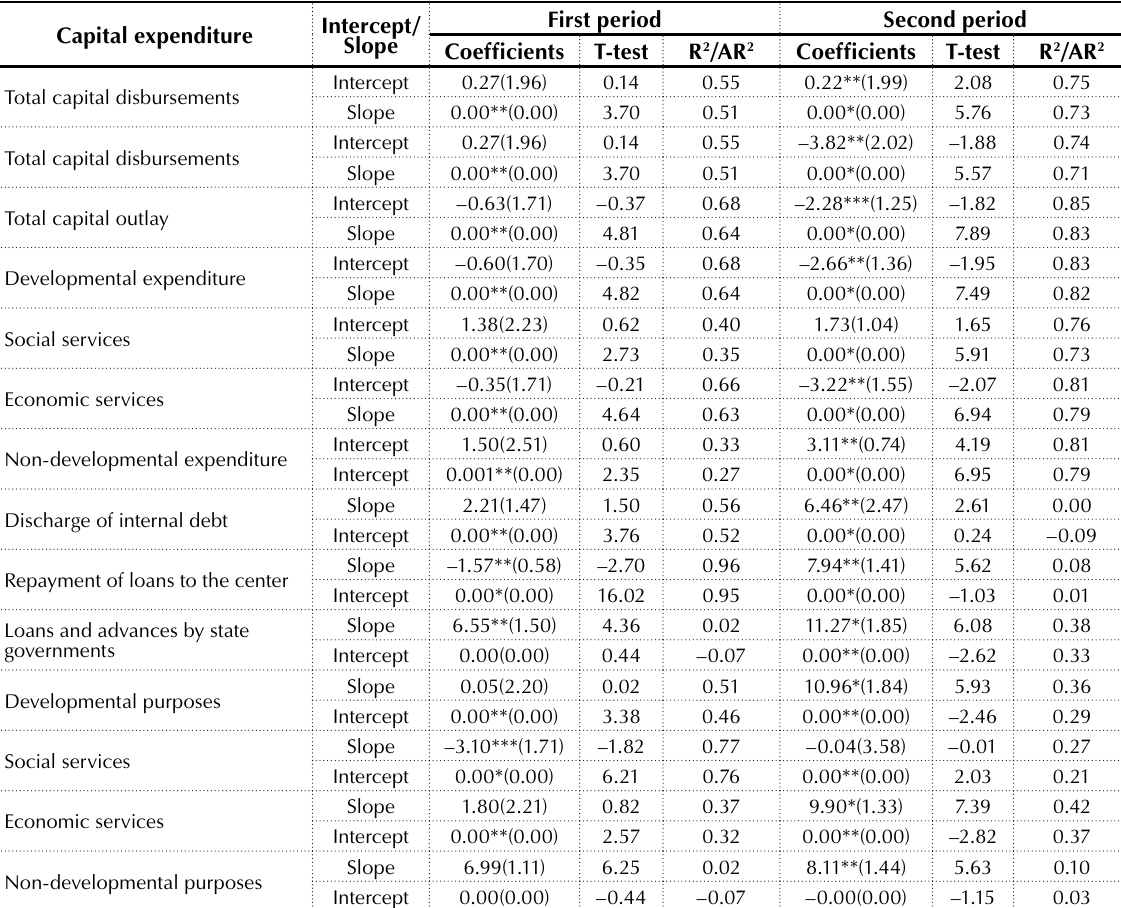
Table 8. Regression results for capital